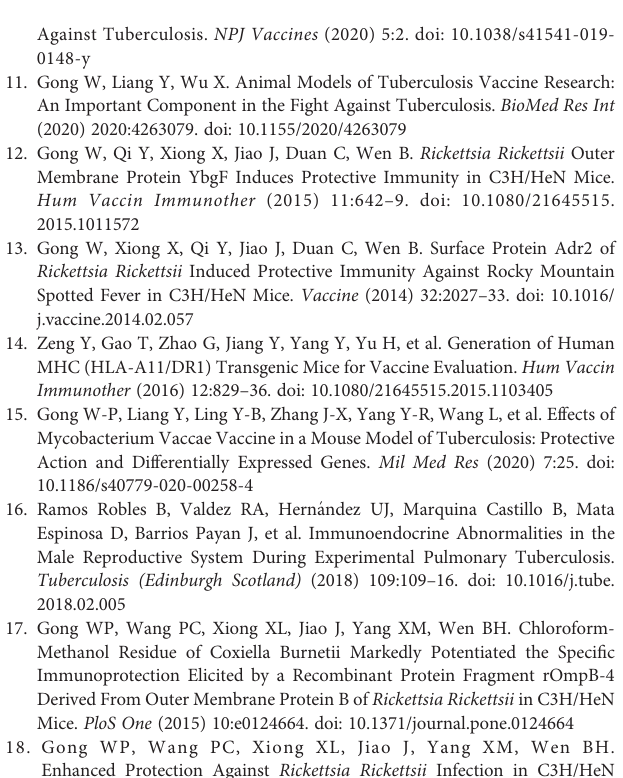
Supplementary Figure 1 | The frequency of lymphocytes, CD3 + CD4 + T cells, CD3 + IFN- g + T cells, CD3 + IL-4 + T cells, and CD4 + CD25 + FoxP3 + Treg T cells in wild- type mice. The splenocytes suspension was prepared, and the frequency of lymphocytes (A, B) , CD3 + CD4 + T cells (A,C) , CD3 + IFN- g + T cells (A, D) , CD3 + IL-4 + T cells (A, E) , and CD4 + CD25 + FoxP3 + regulatory T cells (A, F) was quanti fi ed with BD IntraSure ™ kit. The differences in the frequency of cells among PBS, BCG, and MP3RT groups were analyzed with the one-way analysis of variance (ANOVA) or Kruskal-Wallis test according to the data normality homogeneity of variances. All data were shown as mean + SEM ( n = 3). P <0.05 was considered signi fi cantly different. *, P